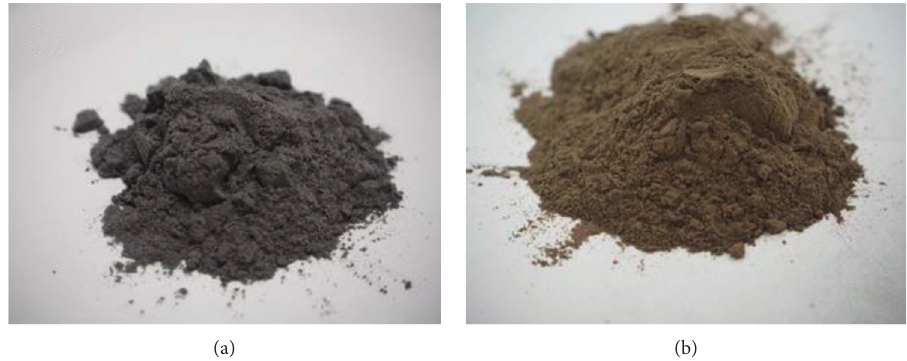
Figure 1: The fly ashes used in this study. (a) BLCP fly ash (FAR). (b) Mae Moh fly ash (FAM).